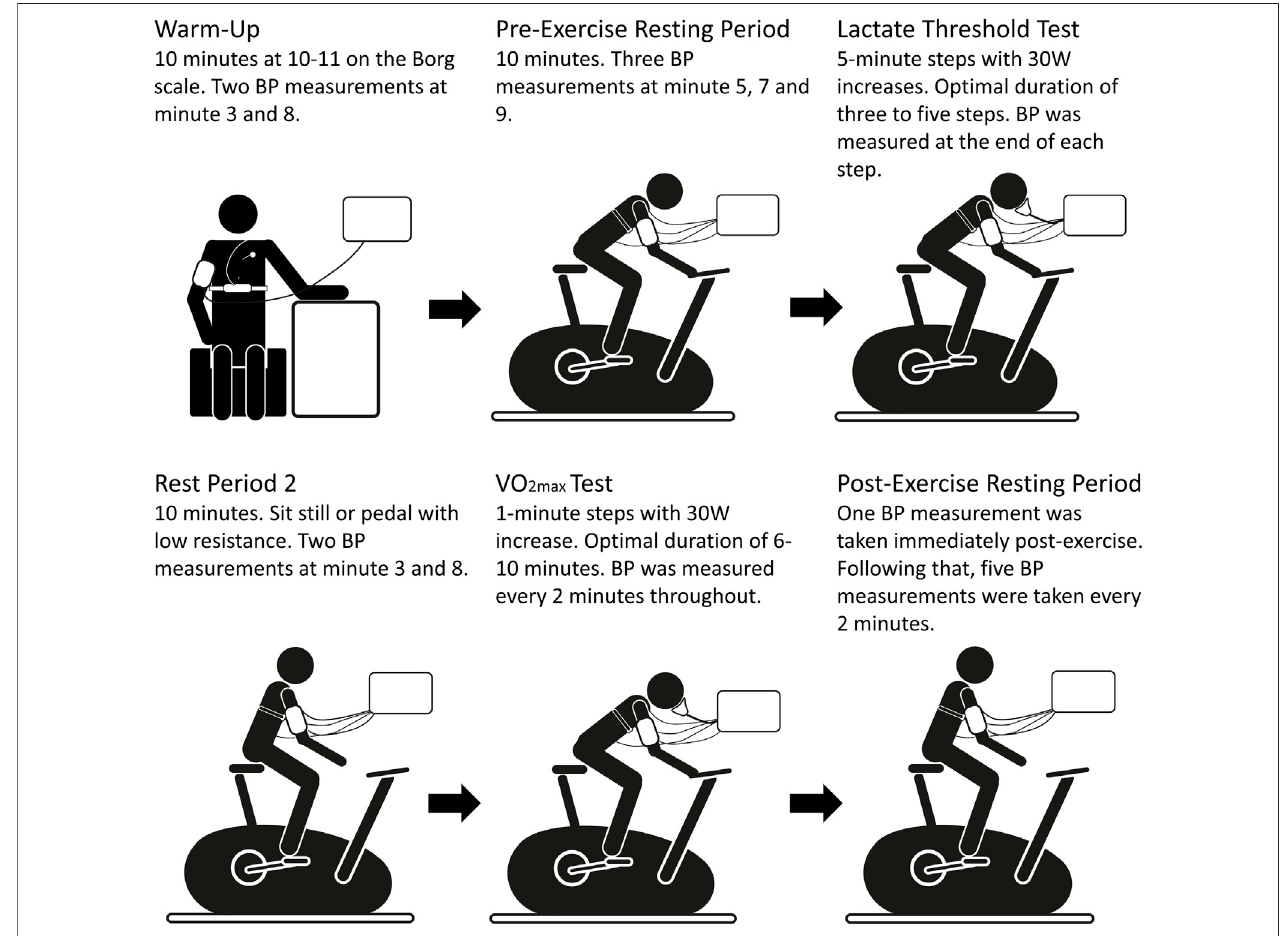
FIGURE 1 | Illustration of the test protocol. BP, Blood